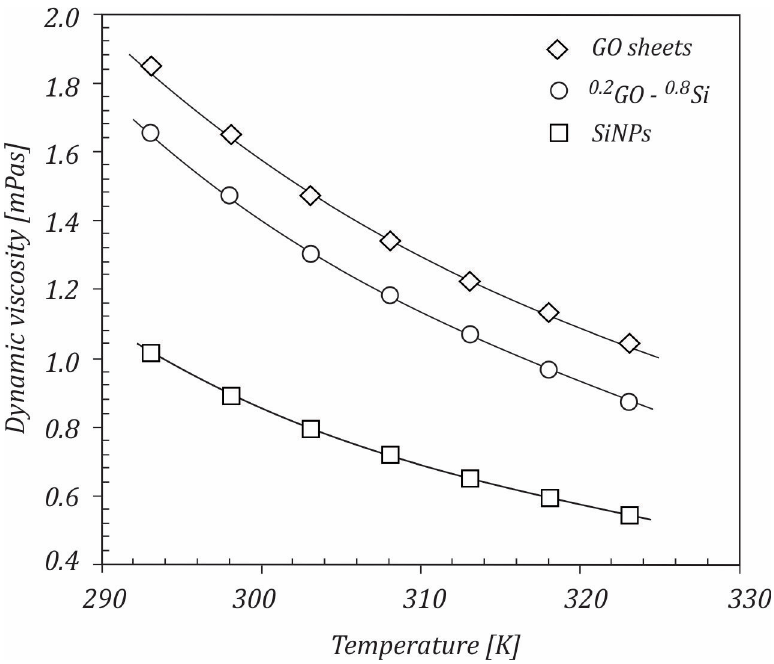
Figure 8. Comparison of the hybrid nanofluid with the water-based GO and Si nanofluids. The dynamic viscosity values for mono and hybrid nanofluids were correlated by In the order comparing of the current results with the results reported in the open lit- means of an exponential equation as a function of reduced temperature, defined as 𝑇 (cid:3045) = erature, the weight concentration is converted into the volume fraction using the following (cid:3021) equation [30]: : (cid:3021) (cid:3116)